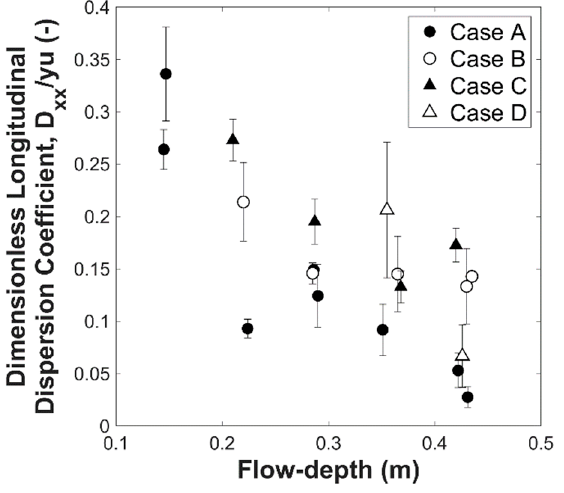
Figure 9. Relationship between dimensionless Longitudinal Dispersion Coefficient (Longitudinal Dispersion Coefficient divided by flow-depth and mean velocity) and flow-depth (Cases A–D).